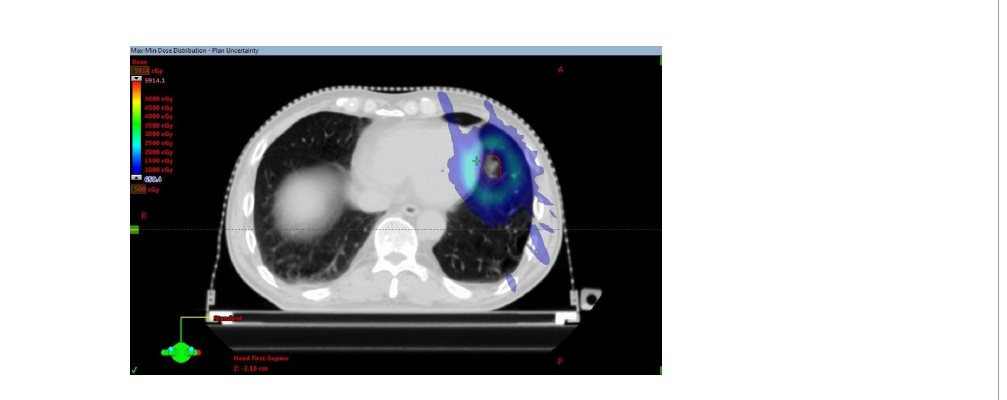
FIGURE 4 Max-min dose examples from patient 2. The red contour represents the